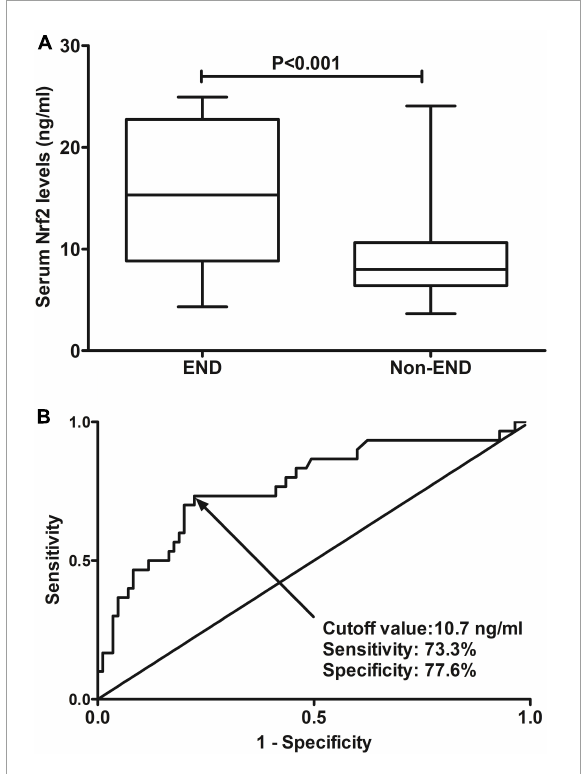
FIGURE4 Predictive ability with respect to serum nuclear factor erythroid 2-related factor 2 (Nrf2) levels for risk of early neurologic deterioration (END) after acute supratentorial intracerebral hemorrhage (ICH). (A) Comparison of serum Nrf2 levels between patients with END and those who did not present with END. (B) Discriminatory capability of serum Nrf2 levels for END under the receiver operating characteristic (ROC) curve. Serum Nrf2 levels were markedly higher in patients suffering from END than in those without development of END ( P < 0.001). Serum Nrf2 levels statistically significantly predicted END after acute stroke ( P < 0.001). Nrf2 indicates nuclear factor erythroid 2-related factor 2; END, early neurologic